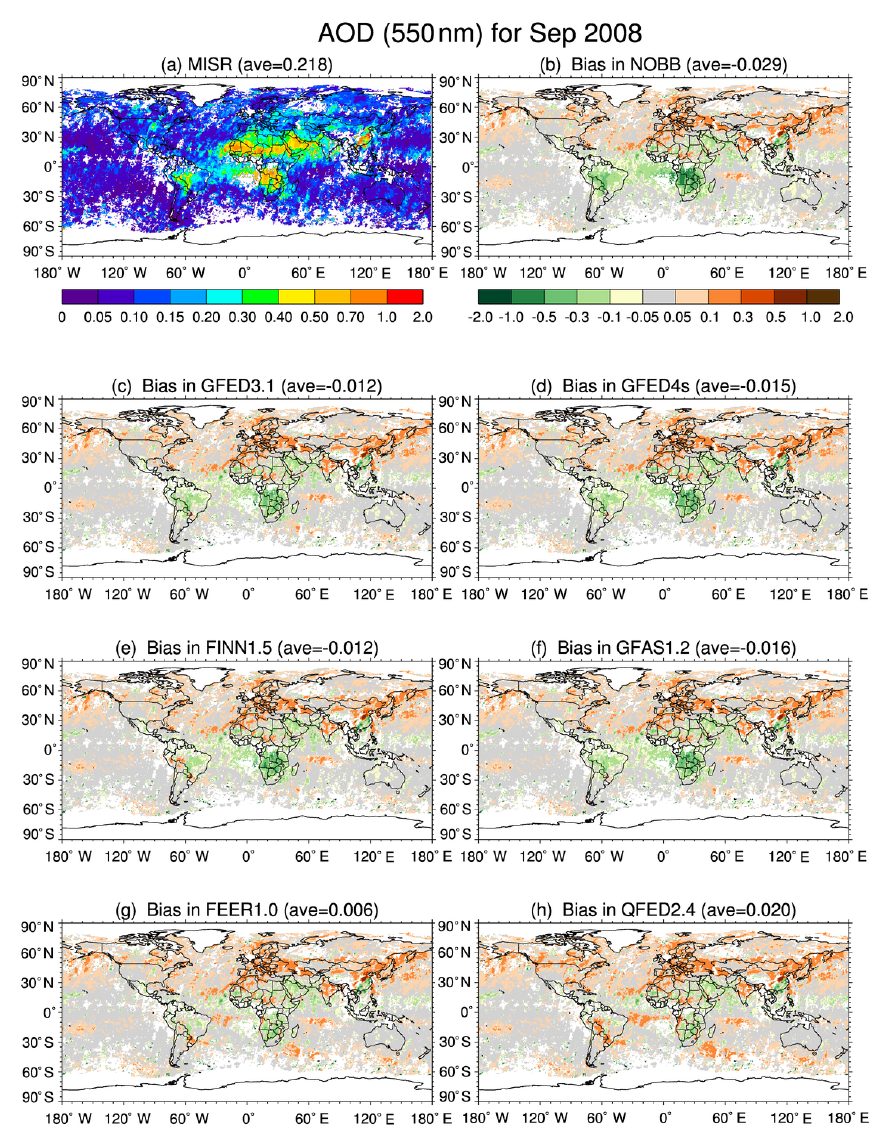
Figure 5. (a) The spatial distribution of monthly mean AOD at 558nm for September 2008 from MISR with white representing missing values. The global average value (ave) is shown in parentheses. Panels (b) – (h) are for GEOS model biases (i.e., model at 550nm minus MISR at 558nm) in seven model experiments, i.e., bias in (b) NOBB, (c) GFED3.1, (d) GFED4s, (e) FINN1.5, (f) GFAS1.2, (g) FEER1.0, and (h)